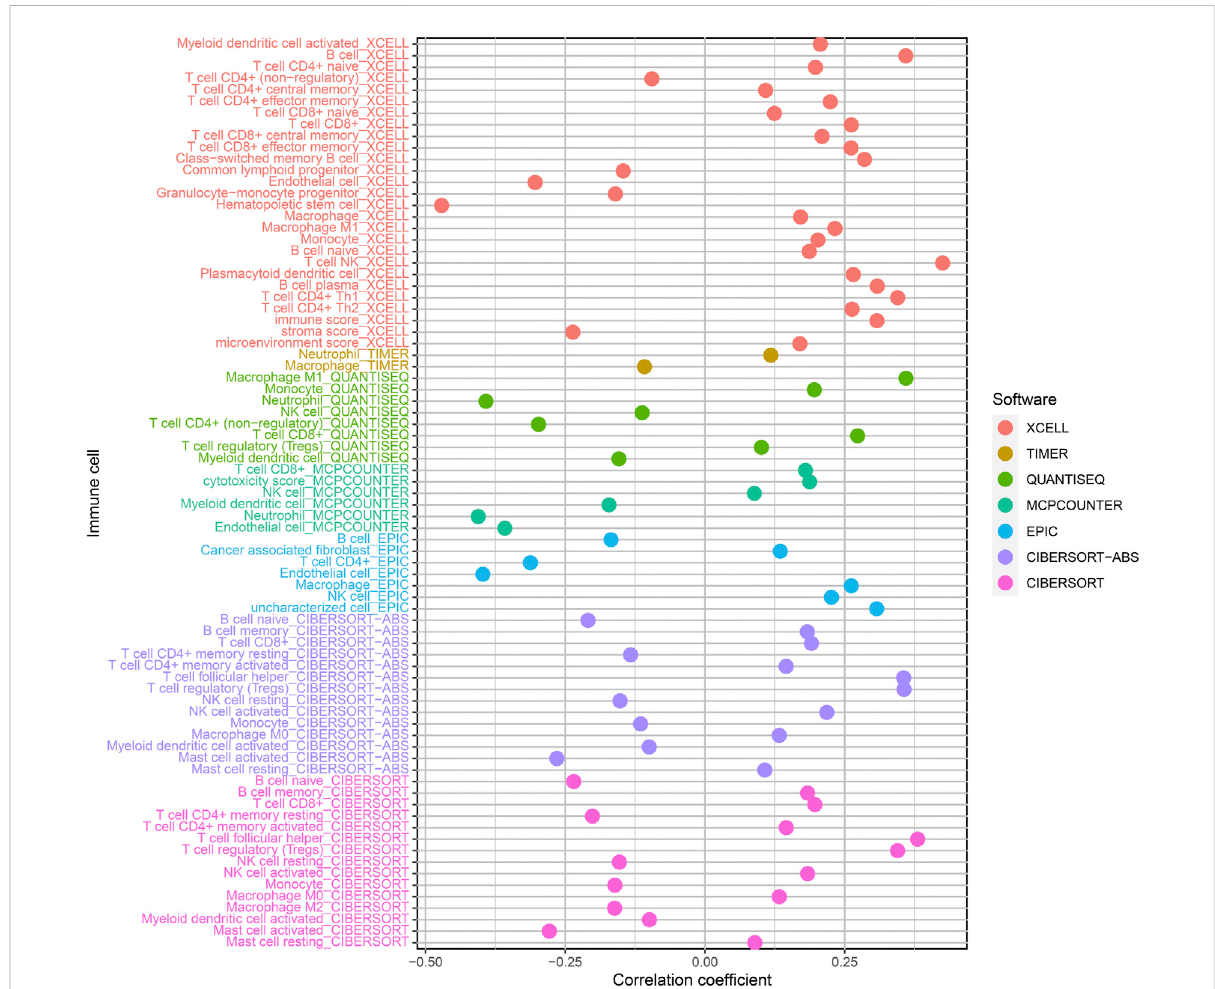
FIGURE 6 Relationship of risk score and immune cell in fi ltrations of ccRCC samples via : XCELL; TIMER;QUANTISEQ; MCPCOUNTER; EPIC; CIBERSORT- ABS and CIBERSORT.